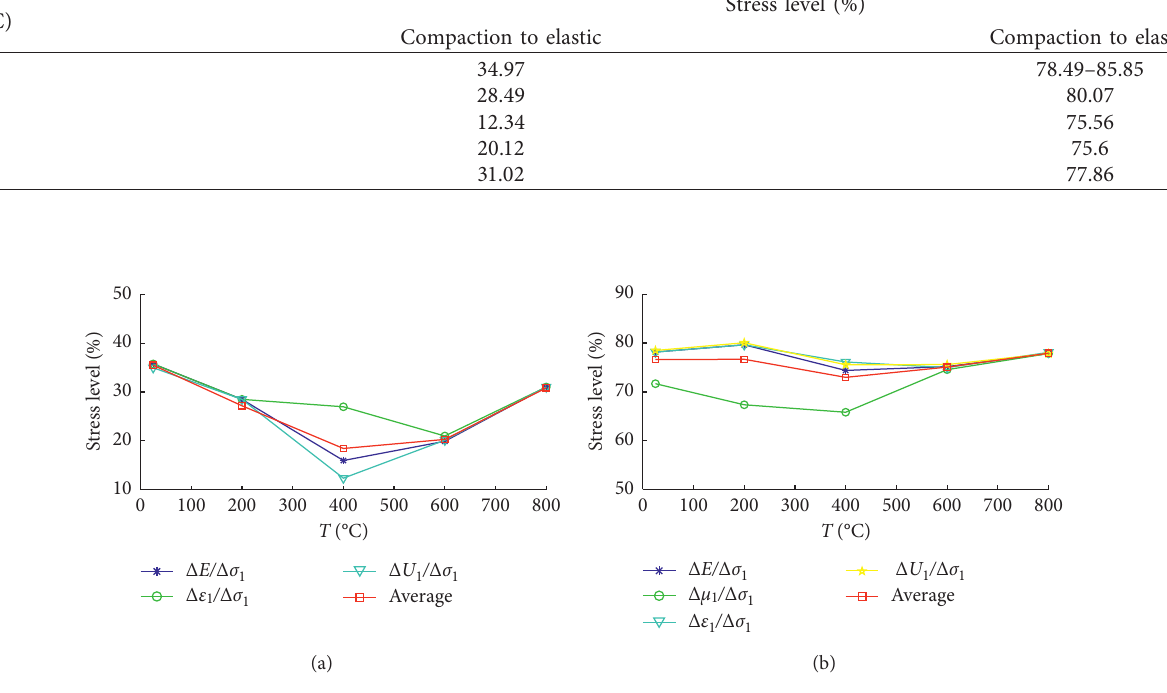
Figure 9: Relationship between the transition threshold of the rock mechanical characteristics and temperature. (a) Compression-to- elasticity transition. (b) Elasticity-to-plasticity